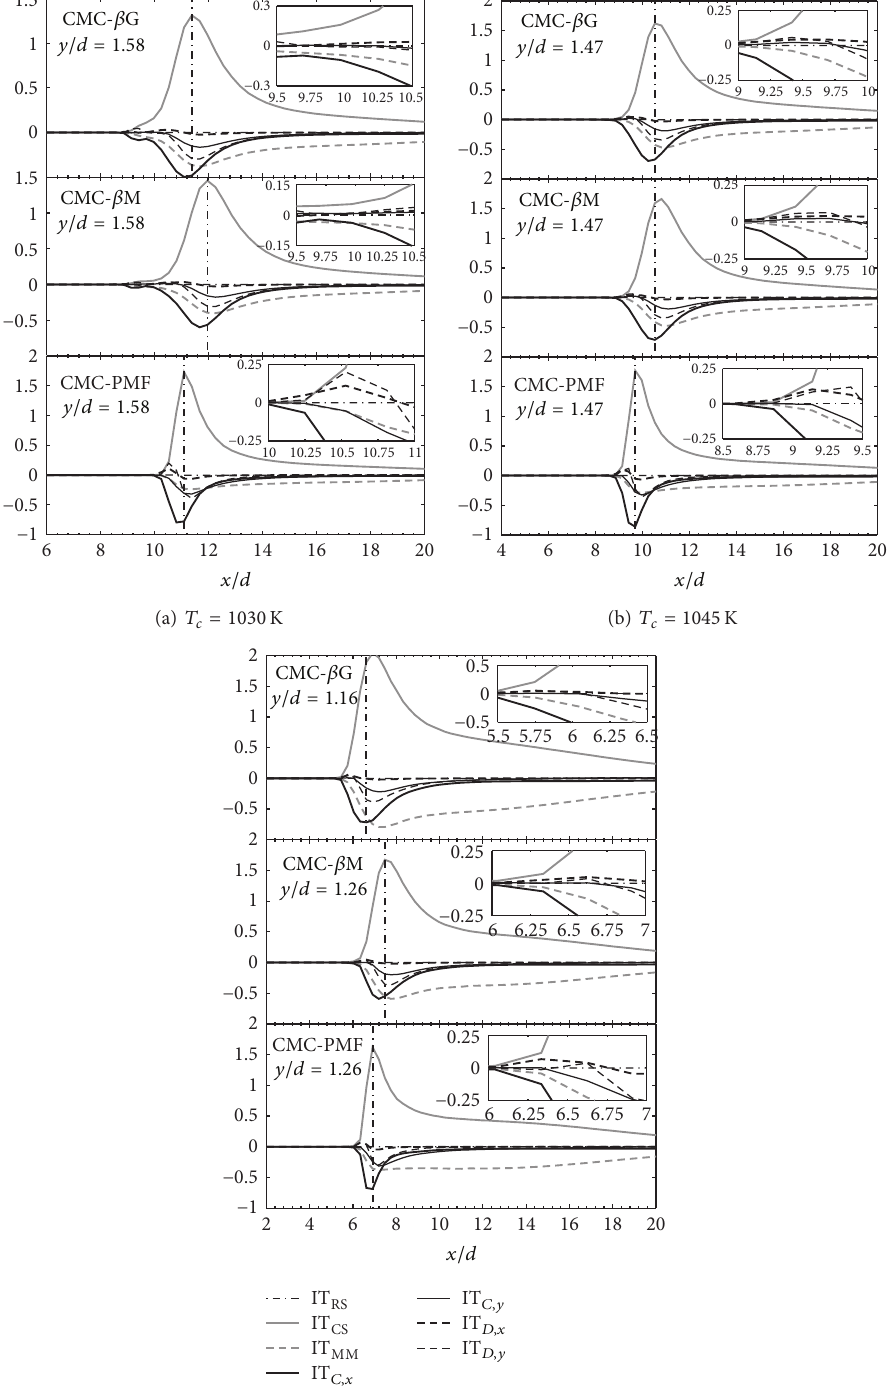
Figure 7: Axial profiles of the Integrated Transport (IT) budget of the steady-state 𝑄 𝑇 equation (integrated r.h.s. terms of (2)) obtained using thethreeCMCrealisations:(a) 𝑇 𝑐 = 1030 K,(b) 𝑇 𝑐 = 1045 K,and(c) 𝑇 𝑐 = 1060 K.Thebottom,middle,andtoppanescorrespondtoCMC- 𝛽 G, CMC- 𝛽 M, and CMC-PMF, respectively. The indicated 𝑦/𝑑 values correspond to the radial locations of stabilisation. The vertical dash-dotted : radiative source; IT : chemical source; IT : micromixing; IT 𝐶,𝑥 : axial convection; IT 𝐶,𝑦 : lines correspond to the stabilisation heights. IT RS CS MM radial convection; IT 𝐷,𝑥 : axial diffusion; IT 𝐷,𝑦 : radial diffusion. All terms are scaled down by a factor of 10 6 and the units are